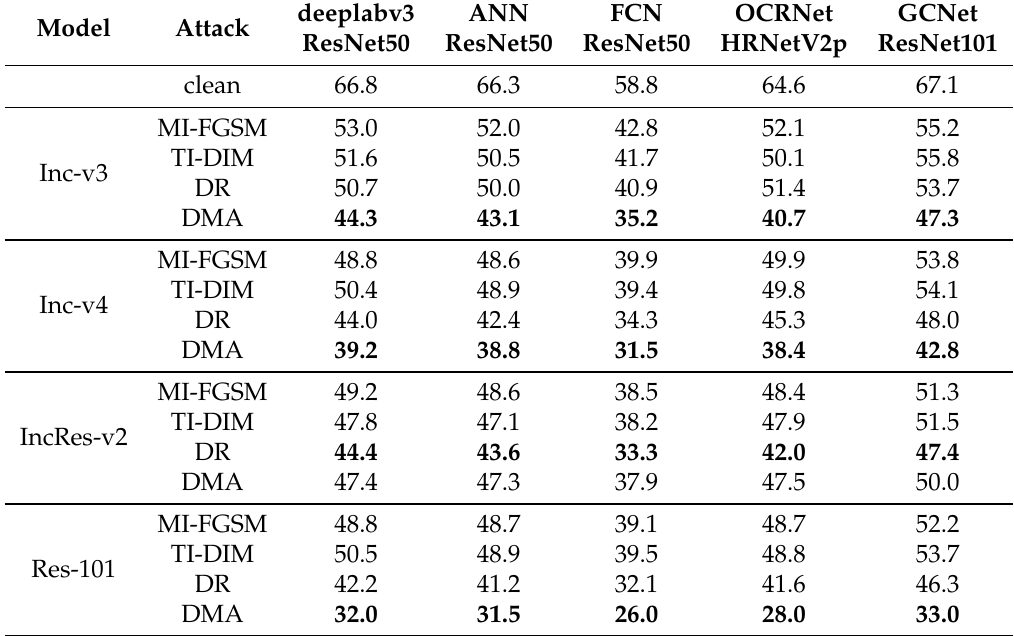
Table 5. The segmentation results (mIoU) of the adversarial examples crafted by DR and DMA on Inc-v3, Inc-v4, IncRes-v2, and Res-101,